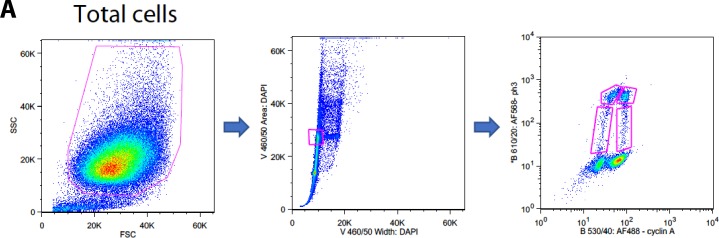
Sorting strategy.Flow cytomety diagrams showing the gates used for FACS.